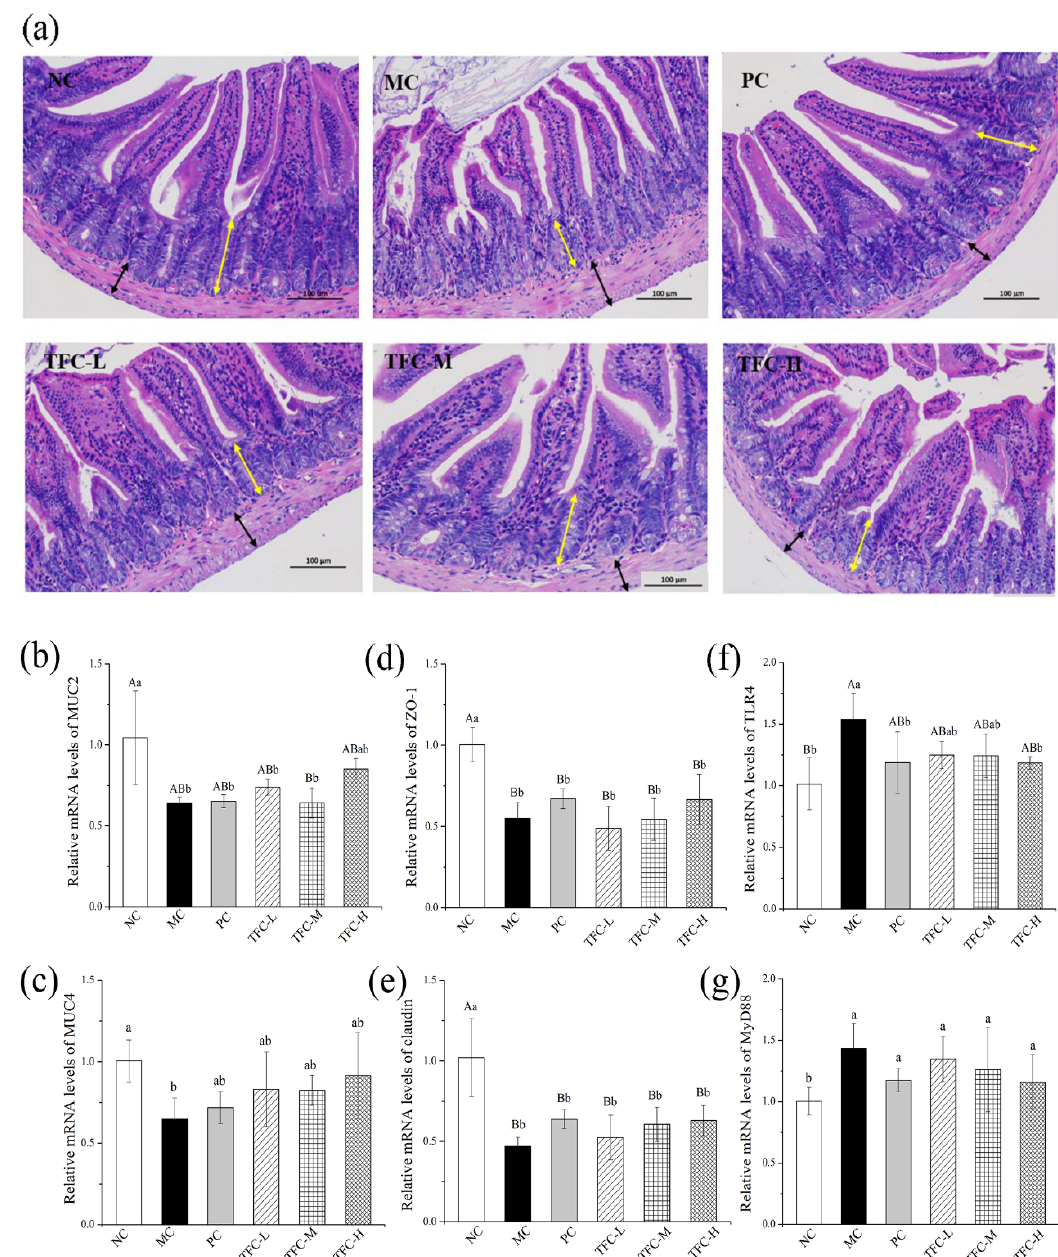
Figure 8. ( a ) Representative images of intestinal tissue H&E staining (200×) in different groups of mice (yellow arrow indicates crypt depth; black arrow indicates muscular thickness) and the mRNA expression of MUC-2 ( b ), MUC-4 ( c ), ZO-1 ( d ), Occludin ( e ), TLR4 ( f ), and MYD88 ( g ) in small intestine. Different letters indicate significant differences; ab p < 0.05, and AB p < 0.01.